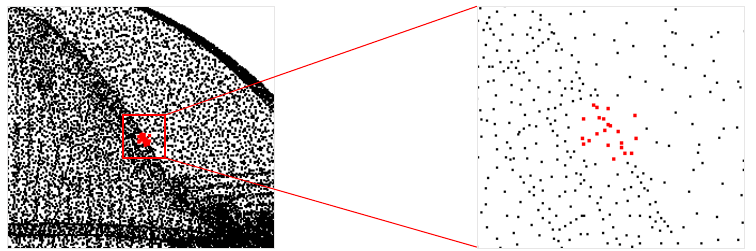
Figure 2. K nearest neighbor set of a point on the edge.